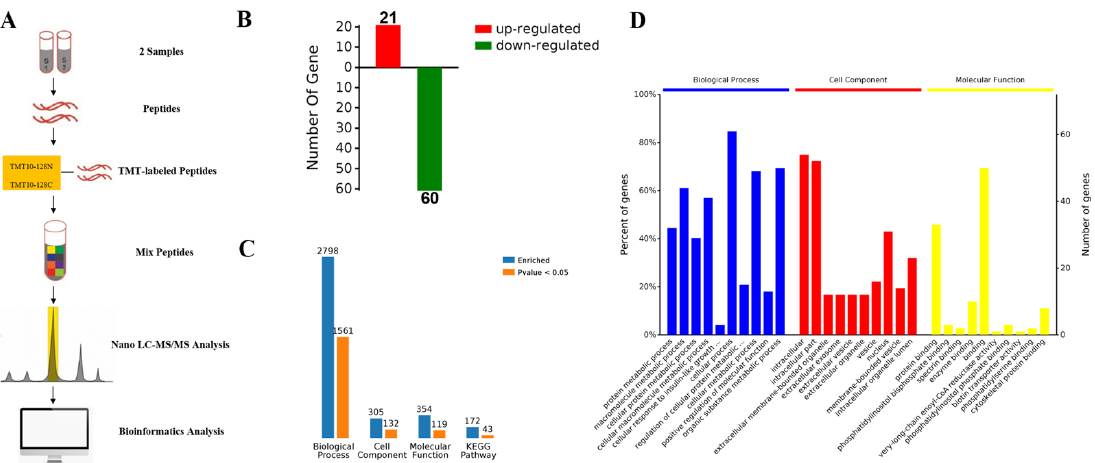
Figure 3. TMT-labeled proteomics analysis. ( A ) The general flow of proteomic analysis. Proteins in SW1990 cells treated with 128N and 128C TMT were labeled with GEM and combined G-6 and GEM, respectively. Labeled proteins were analyzed by LC-MS/MS and differentially expressed proteins were analyzed by bioinformatics. ( B ) Differentially expressed proteins were obtained by sample analysis. ( C ) The differentially expressed proteins were enriched and analyzed. ( D ) GO enrichment analysis.